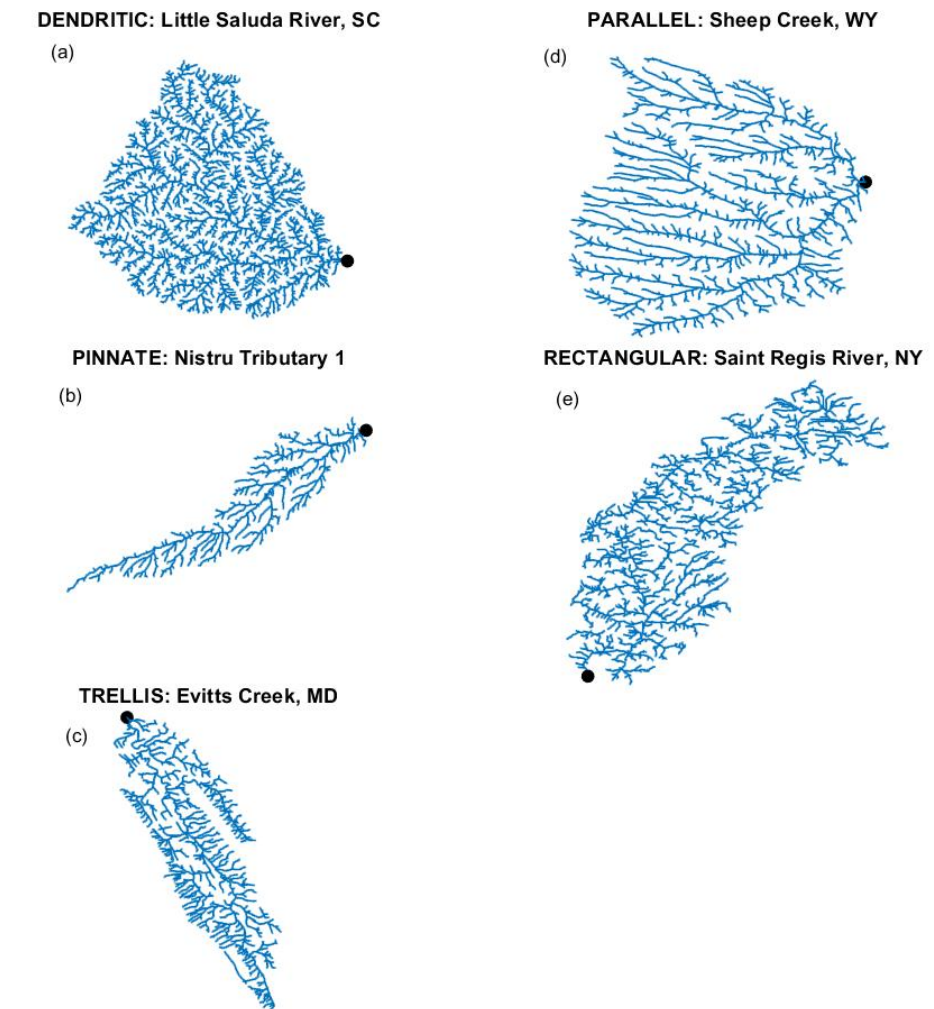
Figure 1. An example channel network from the ( a ) dendritic, ( b ) pinnate, ( c ) trellis, ( d ) parallel, and ( e ) rectangular types. Black dots indicate the basin outlets.